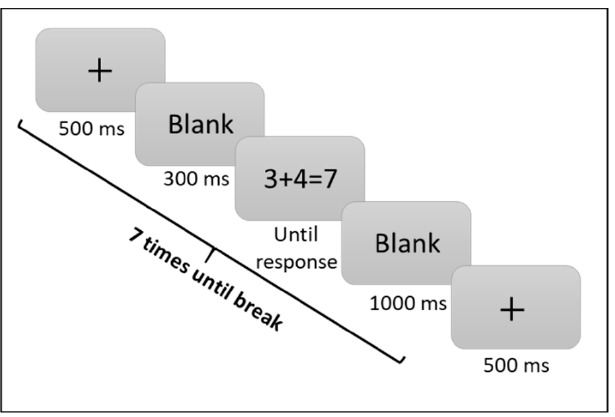
Figure 9. The scheme of the AF task according to the true/false verification task model.